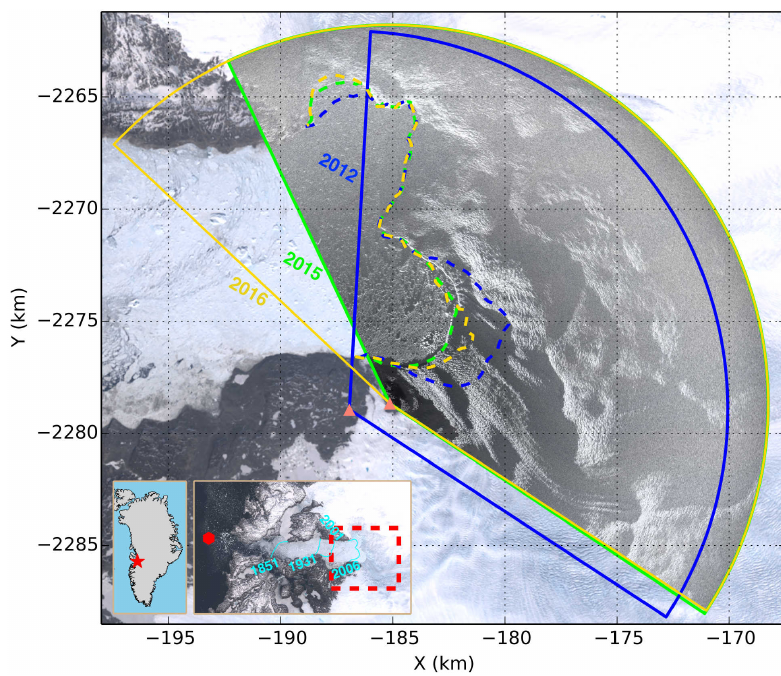
Figure 1. TRI scan areas in 2012 (blue), 2015 (green), and 2016 (yellow). An intensity image of radar backscatter from the 2015 campaign (acquired 9 June 2015) is overlain on a Landsat-8 image (acquired 4 June 2015). Dashed lines indicate glacier front locations derived from satellite images: Landsat-7 on 6 August for 2012; Landsat-8 on 4 June for 2015; and Landsat-8 on 13 June for 2016. Triangles in salmon color show locations of the radar. Dashed red box in the insert outlines the area shown in the main figure. Cyan lines in the insert show the calving front positions in different years, courtesy of NASA Earth Observatory (https://earthobservatory.nasa.gov/Features/Greenland/ greenland3.php). Red hexagon in the insert marks the mooring location where tidal height was recorded in 2015. Red star in the insert shows the location of the study area in Greenland. Coordinates are in polar stereographic projection, corresponding to